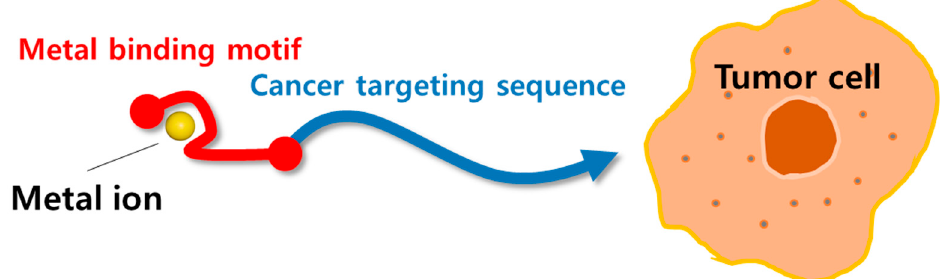
Figure 1. Schematic diagram of peptide-based metal chelate for cancer diagnosis and therapy.